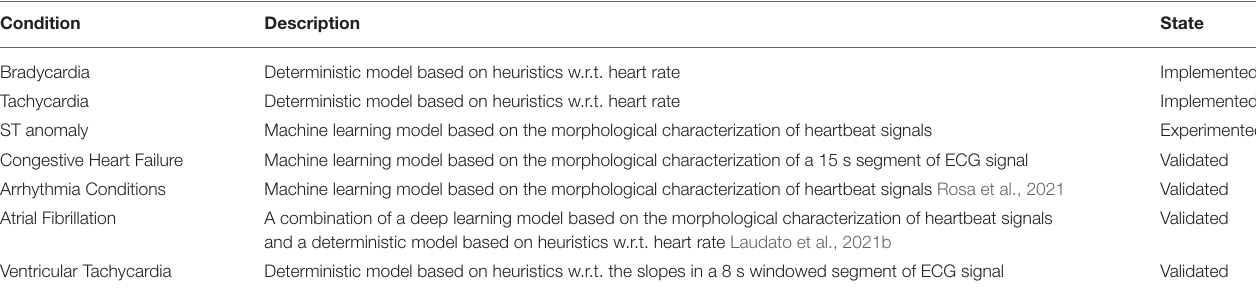
TABLE 1 | Approaches integrated in ATTICUS for the detection of hearth-related anomalies.